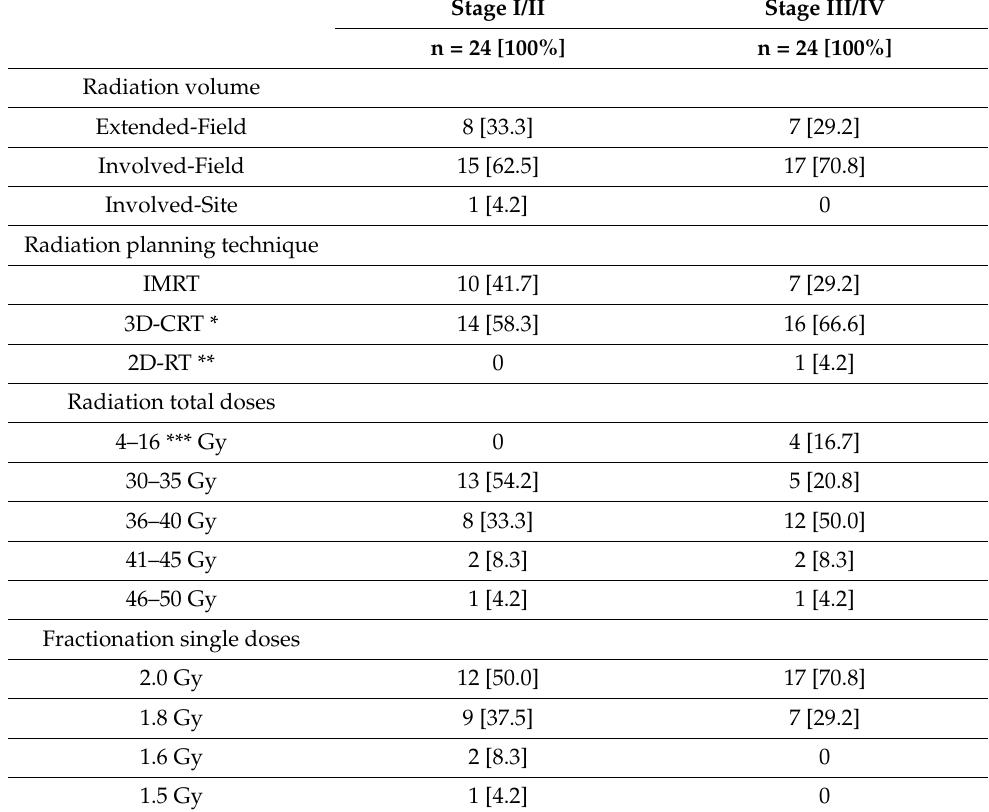
Table 6. Radiotherapy